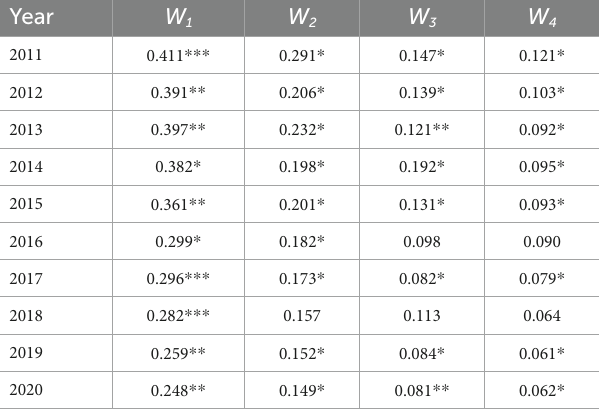
TABLE 7 Moran’s I statistic of the urban digital economy.